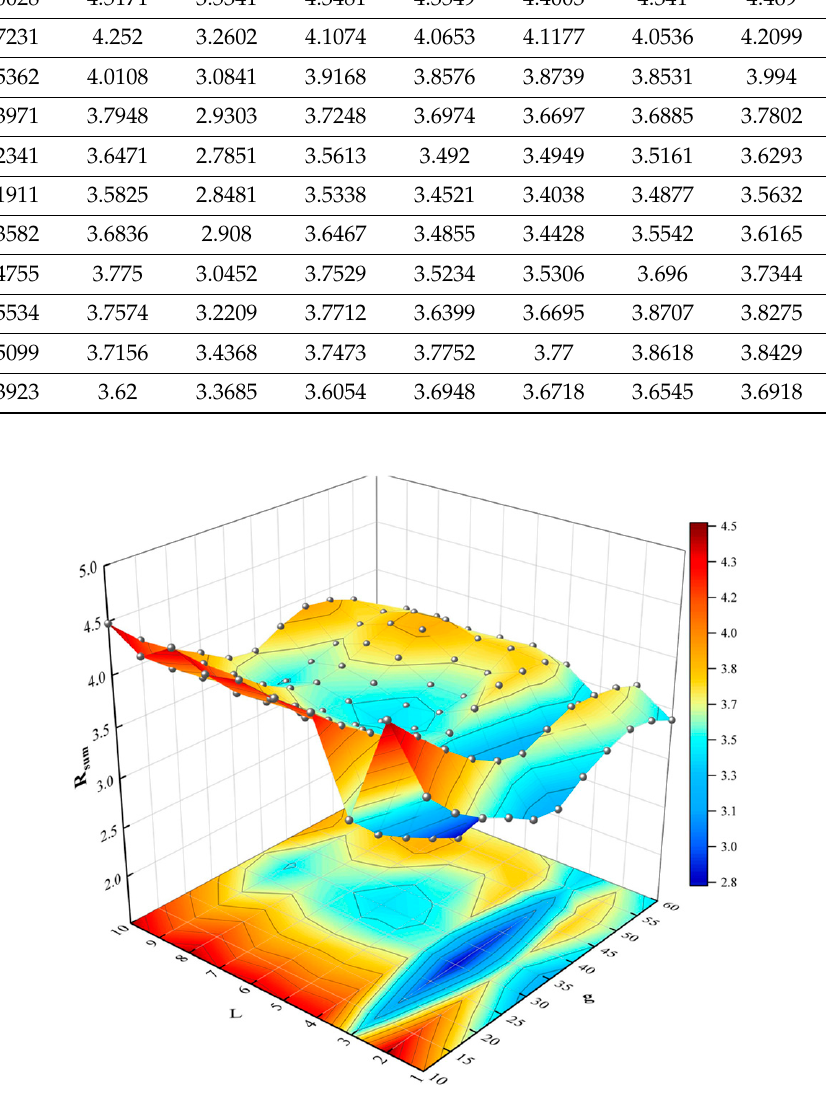
Table 4. Rsum for various values of 𝑔 and 𝐿 .